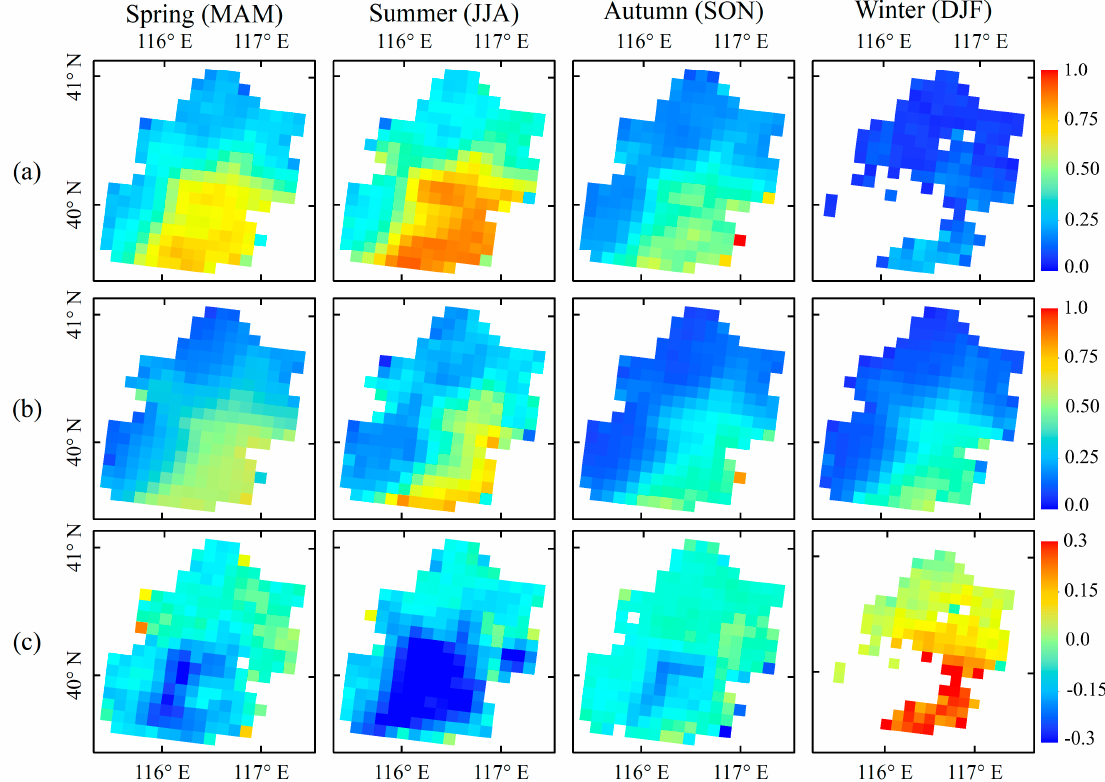
Figure 3. Seasonal mean distributions of aerosol optical depth (AOD) from January 2001 to December 2016, at 10-km, for ( a ) MODIS-Terra C6.1 Dark Target (DT) and ( b ) MODIS-Terra C6.1 Deep Blue (DB); and ( c ) the seasonal mean differences (DB–DT AOD) between the DT and DB algorithms. Spring: March, April, May (MAM); Summer: June, July, August (JJA); Autumn: September, October, November (SON); and Winter: December, January, February (DJF).